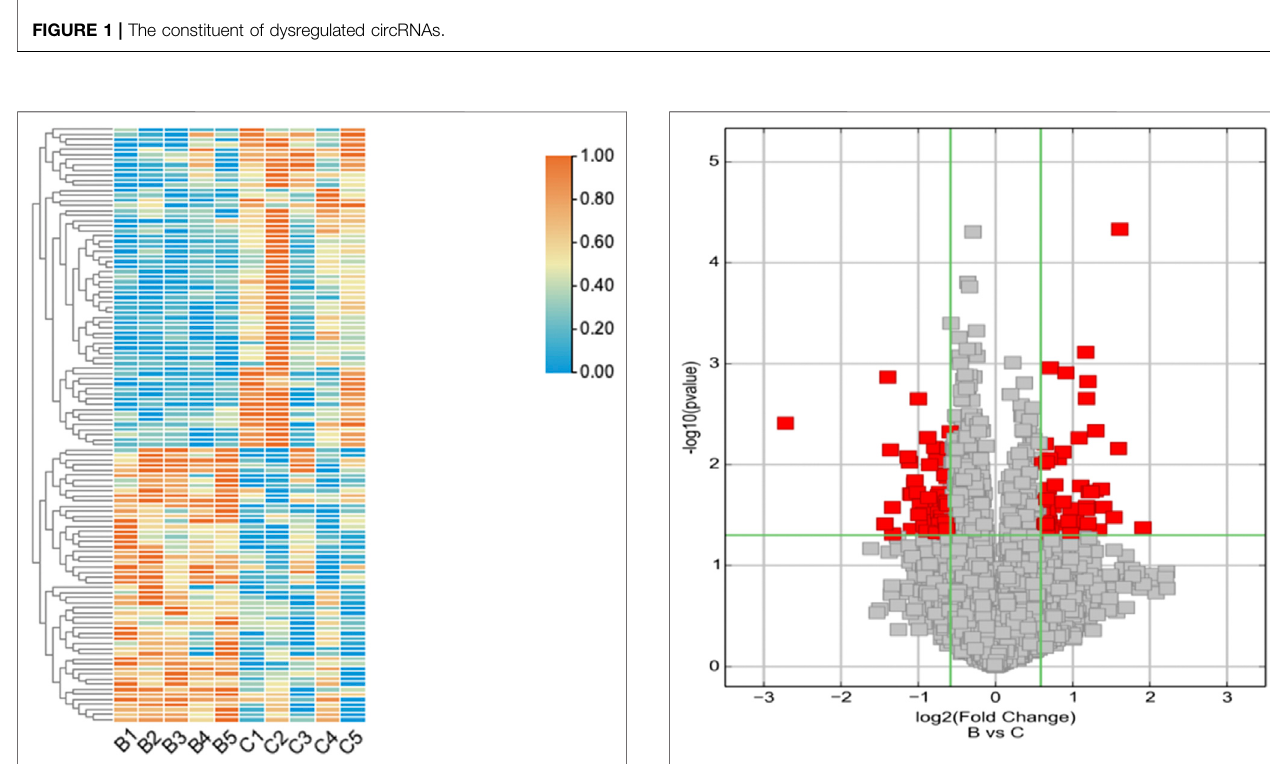
FIGURE 3 | Volcano Plots are used for visualizing differential expression between two different conditions. The vertical lines correspond to 1.5-fold up and down, respectively, and the horizontal line represents a p -value of 0.05. So, the red point in the plot represents the differentially expressed circRNAs with statistical signi fi cance. Group B represented unruptured intracranial aneurysm samples, group C represented ruptured intracranial aneurysm